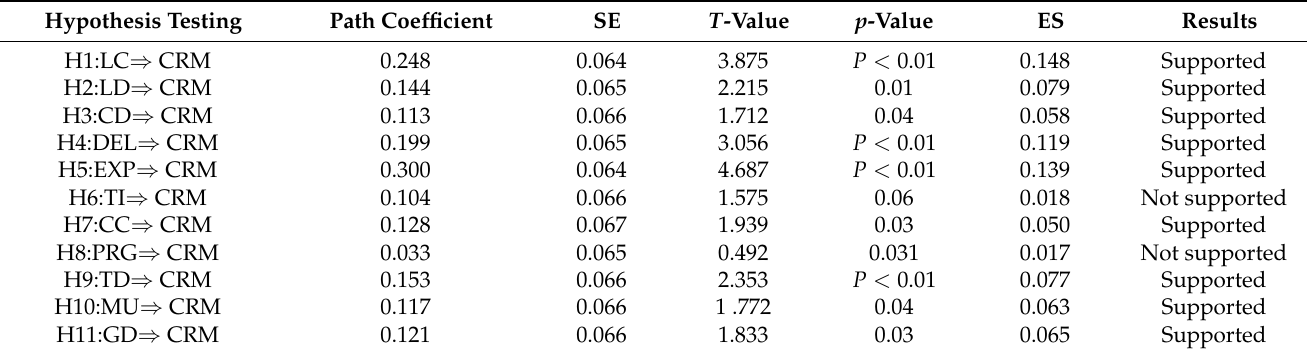
Table 8. Evaluation of formative structural